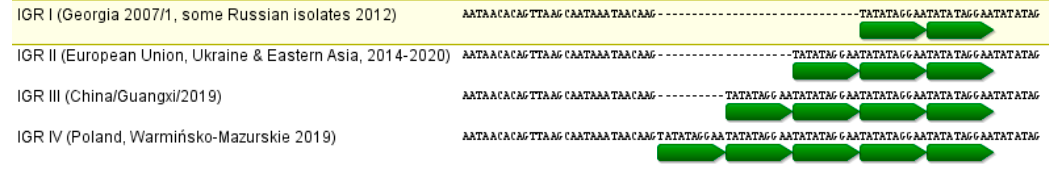
Figure 3. Partial nucleotide sequence alignment of the IGR I73R/I329L in various African swine fever virus (ASFV) isolates. The four known variants of this IGR are shown. Tandem repeat motifs are marked in green.